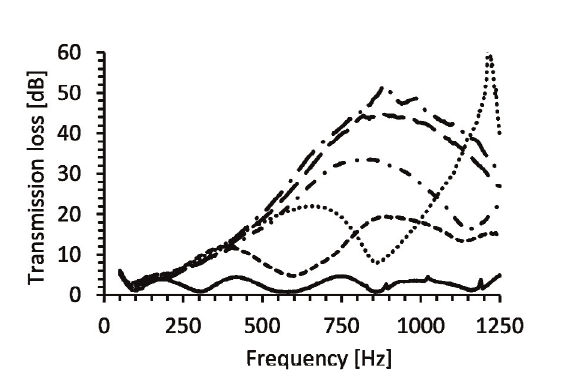
Fig. 17. Transmission loss measurements with up to 6 expansion chambers. 1 chamber (solid line) and 6 chambers (long dash- dotted line) (see Fig.